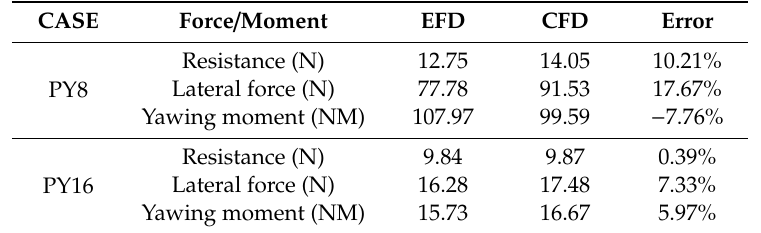
Table 7. Comparison between the predicted and experimental forces and moment in pure yaw tests. CASE